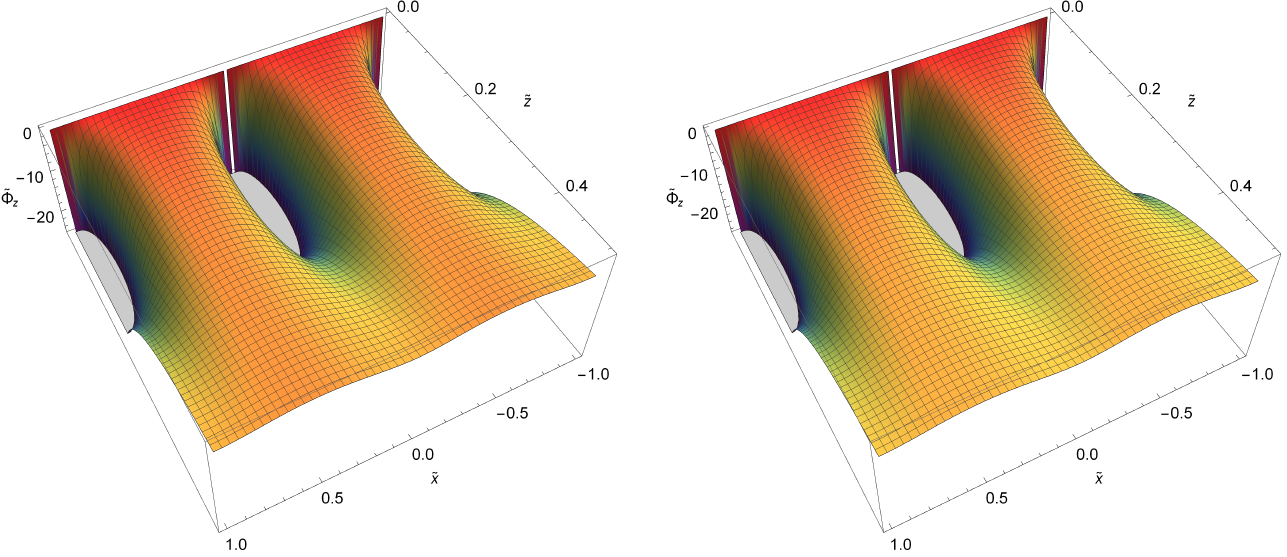
Figure 10. z -component of the rescaled force ˜ Φ z for ˜ λ eff = 1 and ˜ λ eff = 3 (left and right panels,